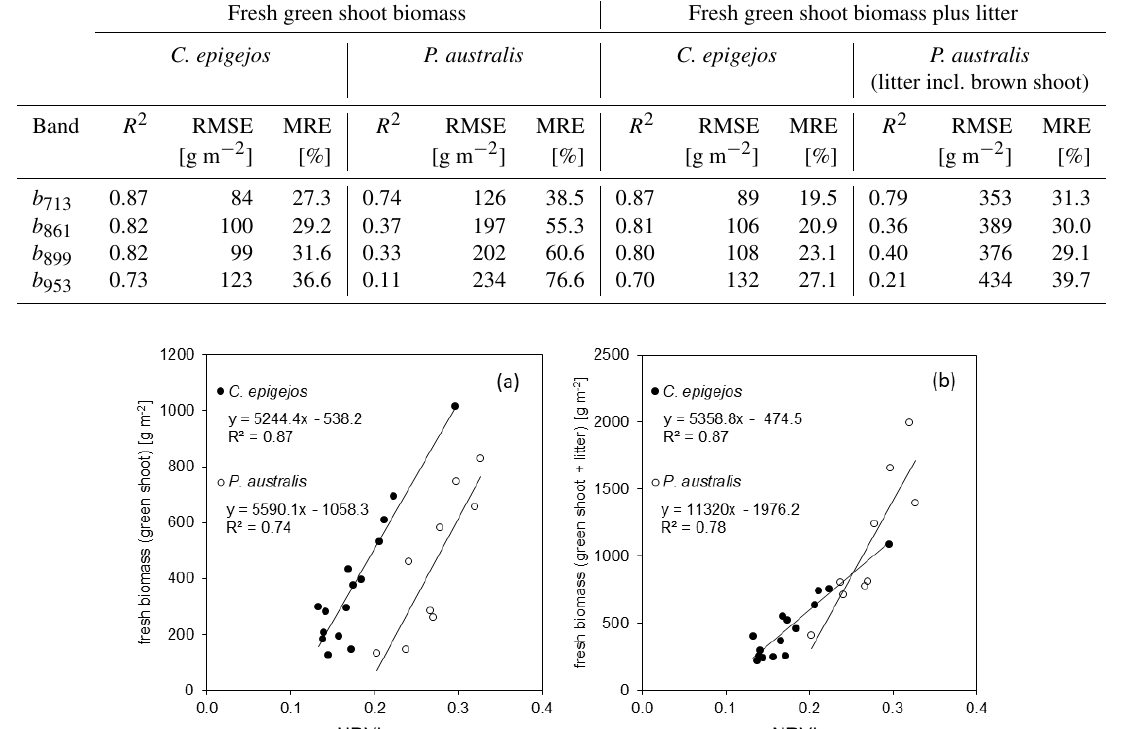
Figure 6. Response of NDVIb713 to fresh green shoot biomass (a) and the sum of fresh green shoot biomass and litter (b) of C. epigejos and P. australis